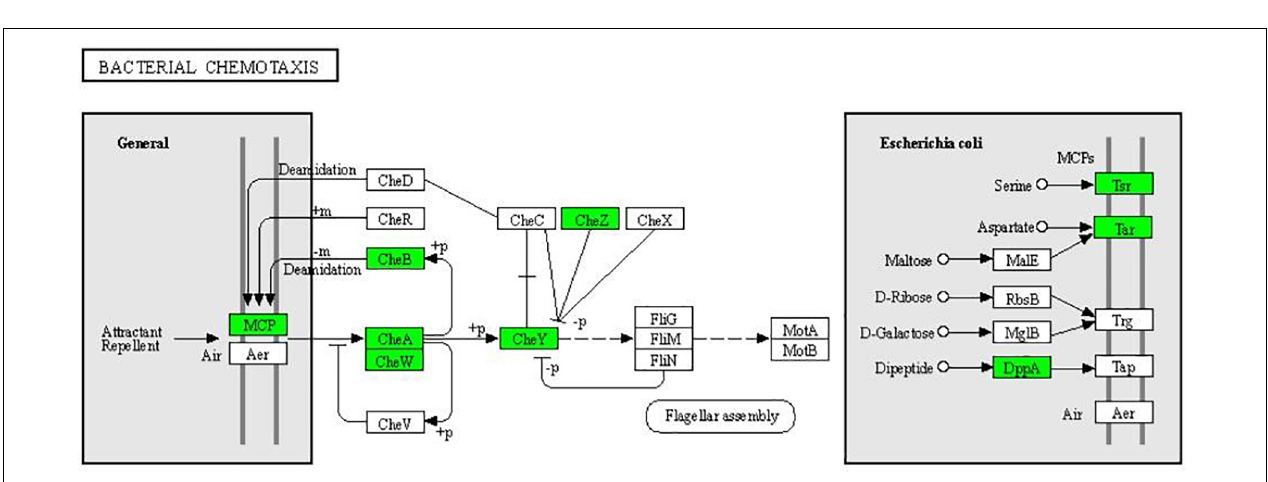
FIGURE 7 | Significantly enriched KEGG pathway: Two-component system (from the KEGG database, green frames represent downregulation, and red frames represent upregulation).